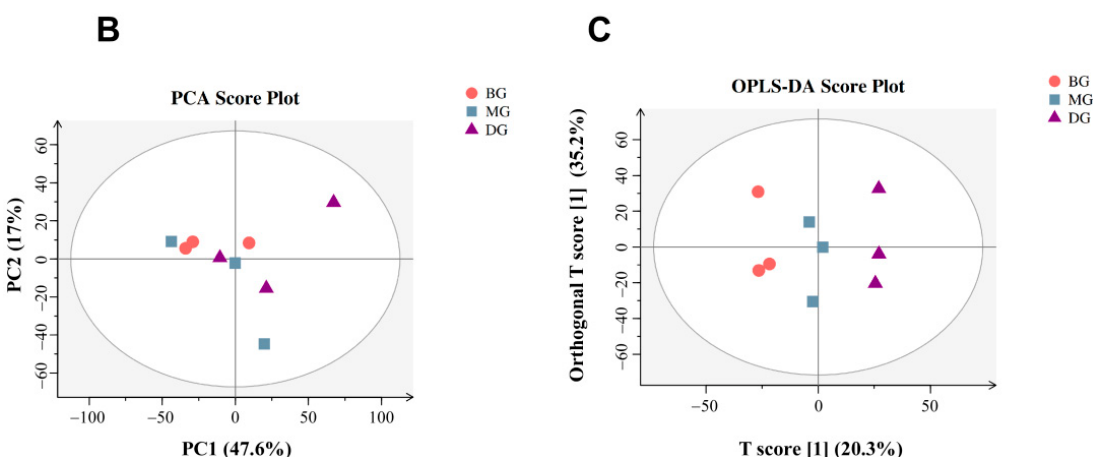
Figure 3. ( A ) Classification map of metabolites; ( B , C ) PCA and OPLS-DA charts.